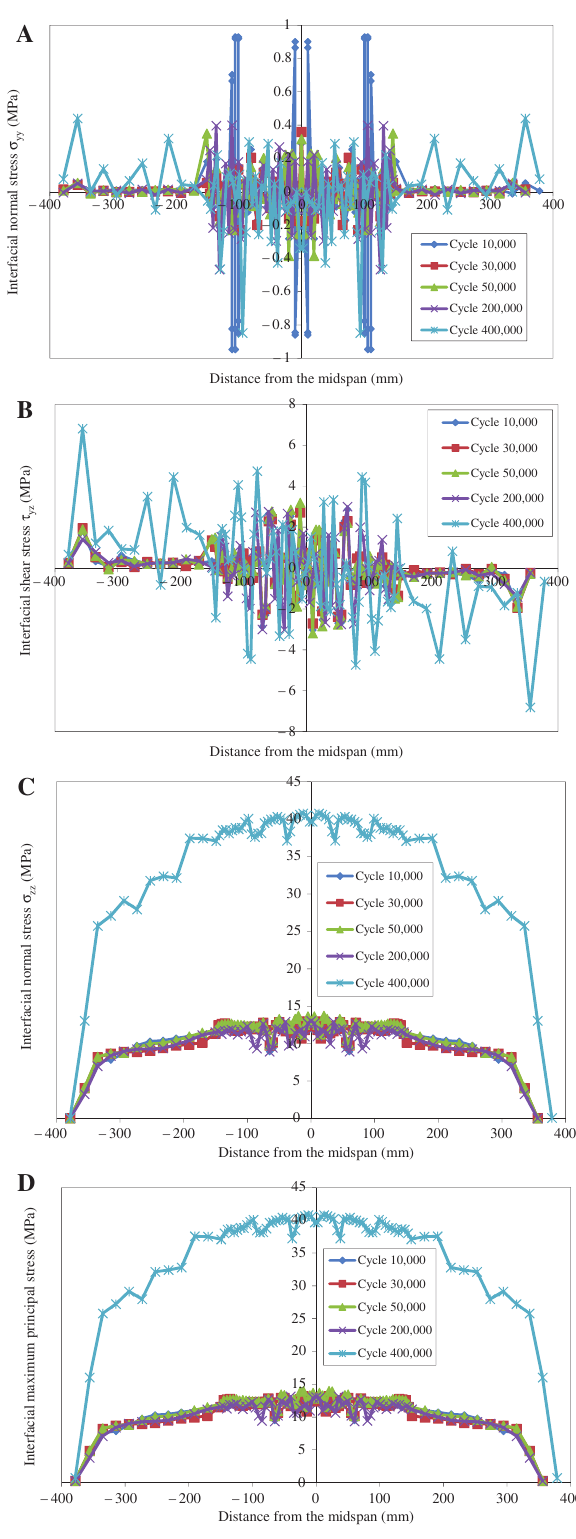
Figure 20: Variations of stress contours along the interfacial adhe- sive elements versus fatigue cycle number. (A) Normal stresses σ , (B) Shear stresses τ , (C) Normal stresses yy yz σ , and (D) Maximum principal zz